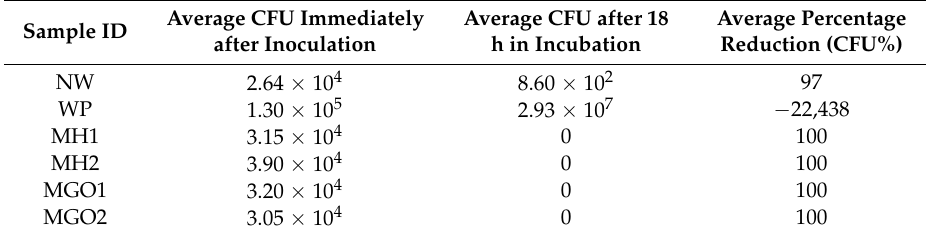
Table 2. Average reduction in colony forming units (CFU) for S. aureus. Negative values indicate bacteria growth.